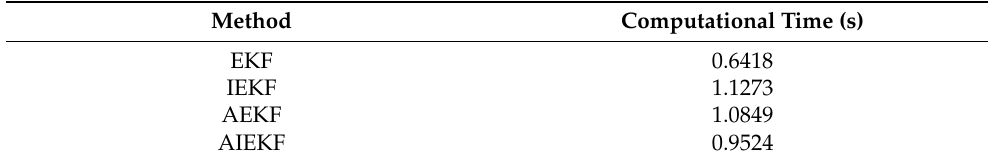
Table 3. Computational burden